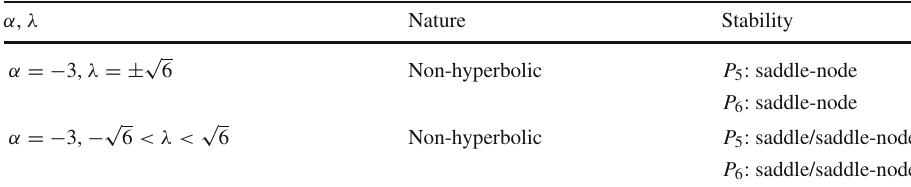
Table 8 Stability of P 5 and P 6 according to range of